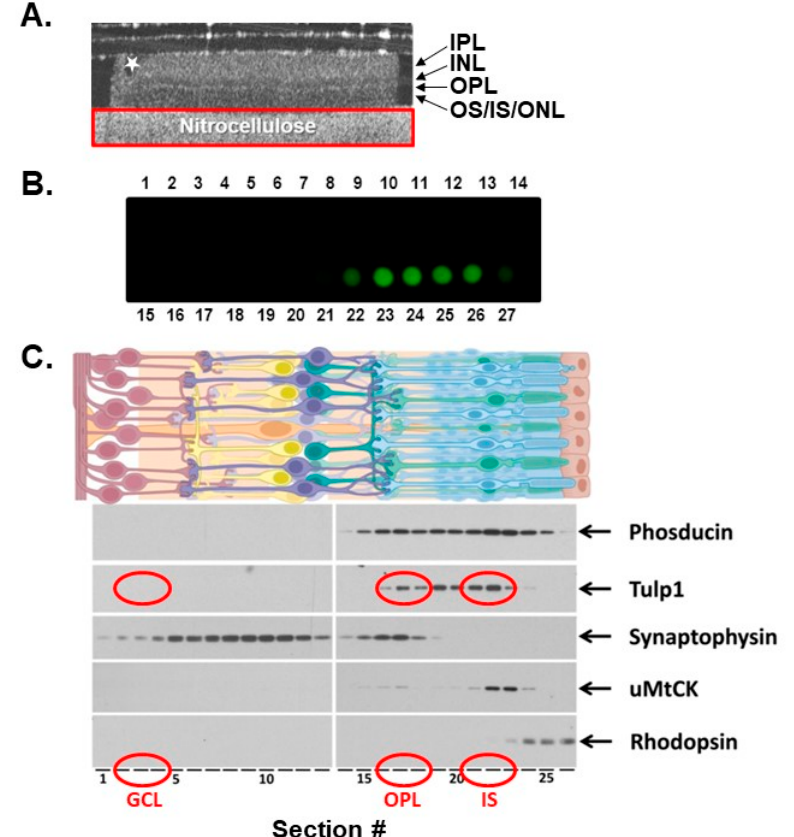
Figure 1. Isolation of Tulp1-containing photoreceptor compartments. ( A ) OCT image of a retinal flat mount preparation to assess the quality of the dissected retina. Any disturbed or folded peripheral edges, highlighted by a star, were removed prior to tangential sectioning. The red rectangle encompasses the nitrocellulose support. ( B ) A dot blot analysis of all serial sections probed with antibodies against rhodopsin. A blot in which only the outermost 4–5 sections corresponding to the photoreceptor OSs were strongly positive for rhodopsin indicated optimally sectioned retinas. ( C ) A schematic illustration of retina showing each cell type. The protein content of each tangential section was analyzed by Western blot probed for known compartment-specific proteins. The five marker proteins included Phosducin, Tulp1, Synaptophysin, uMtCK and rhodopsin. Each lane of the gel represents the protein content of a single 10 μ m section starting from the GCL and progressing through the photoreceptor OSs. The GCL-, IS-, OPL-containing samples used for further analysis are circled in red. To further refine our data, stringent criteria were applied in order for proteins to be considered potential Tulp1 binding partners: (1) proteins must have five or more spectral counts, (2) proteins must be identified by at least two unique peptides, (3) proteins must have a greater than three-fold increase in spectral counts compared to negative controls, and (4) proteins must be identified in at least two of the three independent IP experiments. control, Tulp1 was identified in the IS compartment by 48 unique peptides, corresponding to 63% sequence coverage; and Tulp1 was identified in the synaptic compartment by 28 unique peptides, corresponding to 38% sequence coverage. Following these criteria, there were a limited number of proteins in each compartment analysis that exhibited the strong- est proteomic results. We chose to validate these observed proteins. In the IS, the candi- date proteins include microtubule-associated protein 1B (MAP1B) and Kinesin family